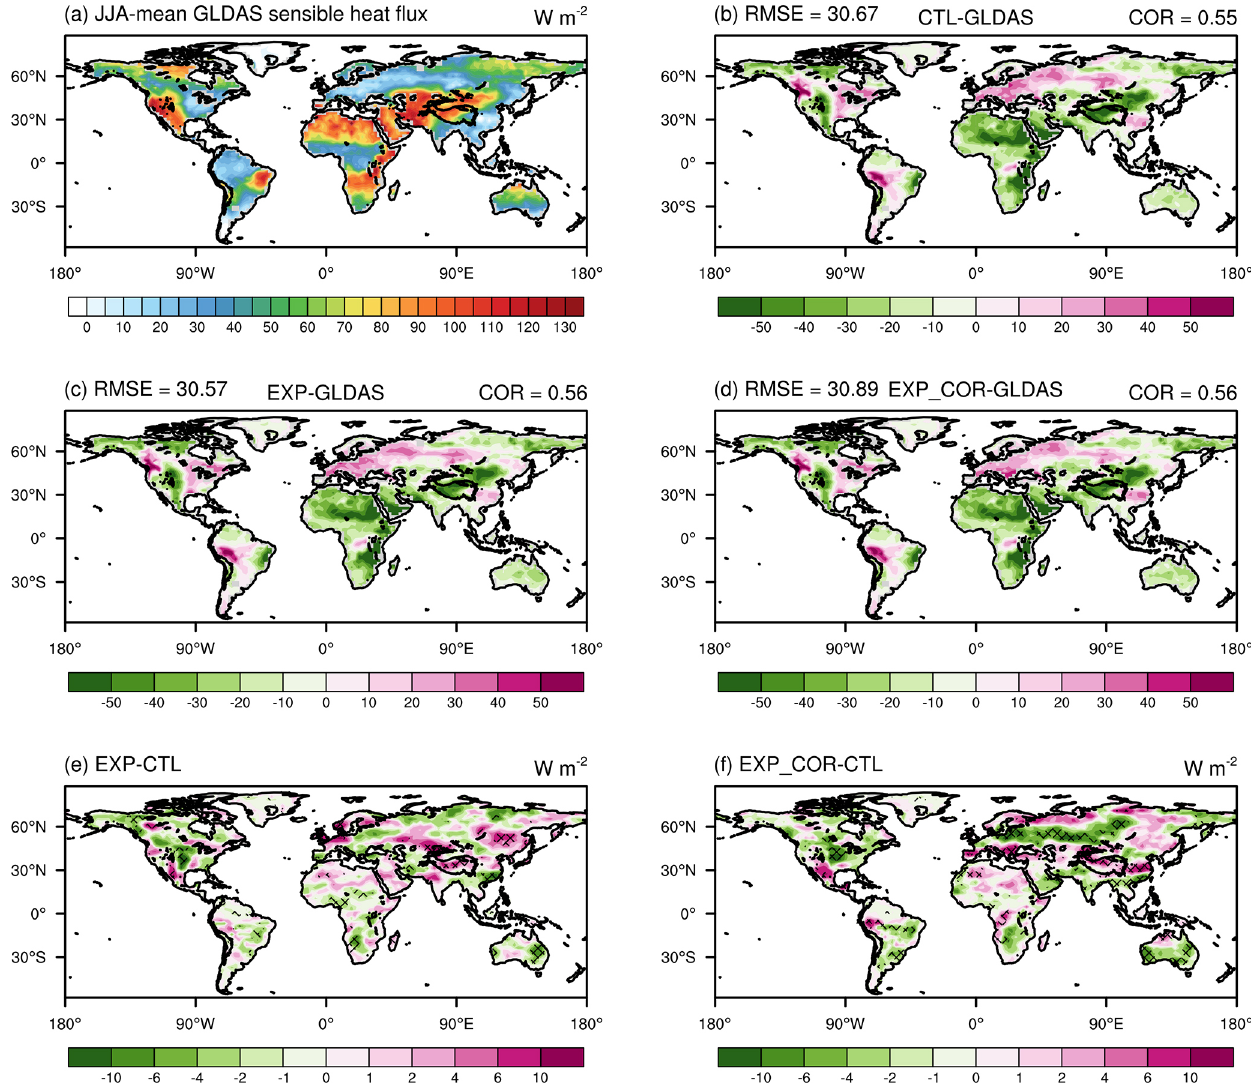
Figure 8. Spatial distributions of the JJA-mean sensible heat flux in (a) GLDAS (upward positive); the biases of (b) CTL, (c) EXP, and (d) EXP_COR with respect to GLDAS; and the differences between (e) EXP and CTL and between (f) EXP_COR and CTL. The crossed areas are significant at the 95% level. The averaged spatial COR and RMSE values for the three simulations are given in (b) – (d)